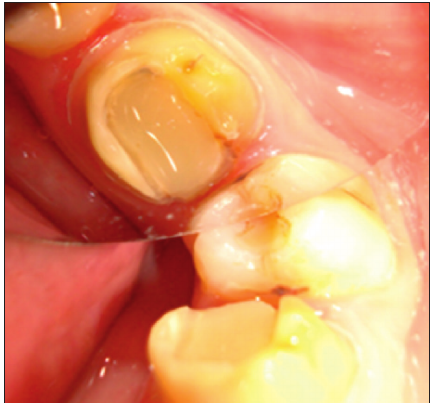
Figure 2: Tooth preparation for endocrown.